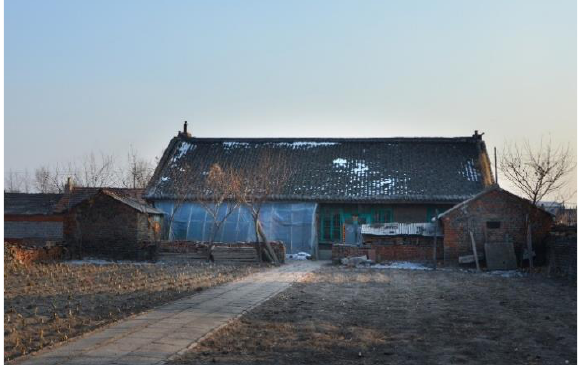
Figure 9. Walls covered with plastic film in the old town of Kaiyuan. Photo by Li Bing, 2017. Figure 10. Demolition in some old towns of Liaoning